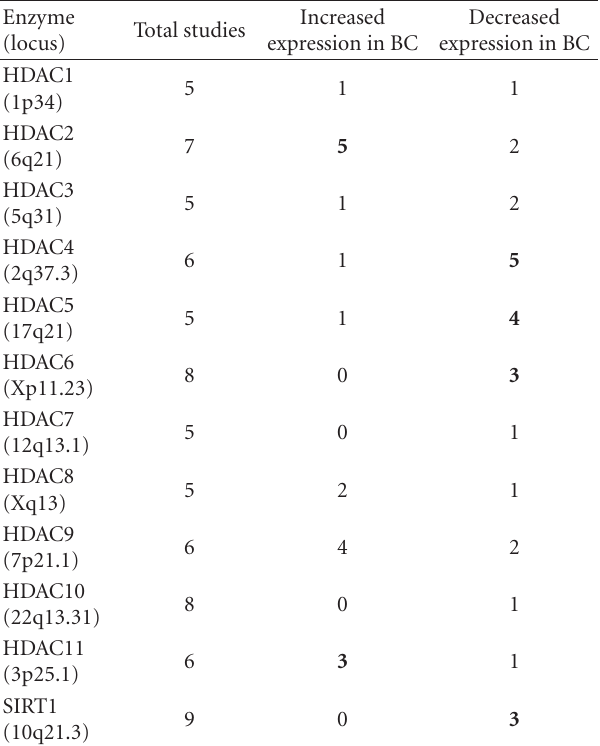
Table 2: Expression of HDACs in breast cancers. Enzyme Increased Decreased Total studies (locus) expression in BC expression in